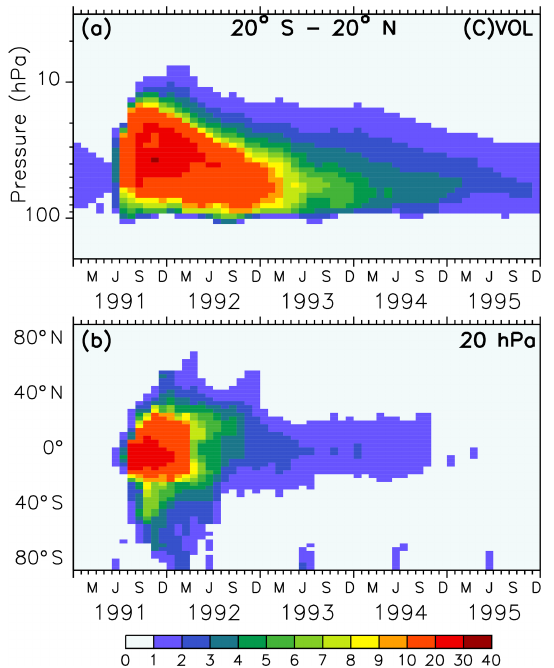
Figure 1. Colours show the monthly averaged liquid aerosol surface area density (10 − 8 cm 2 cm − 3 ) of the volcanic sulfate aerosols in simulations VOL and CVOL in the stratosphere as tropical averaged vertical time series between 20 ◦ S and 20 ◦ N (a) and as latitudinal time series at 20hPa (b) . The intervals of the colour scale are not